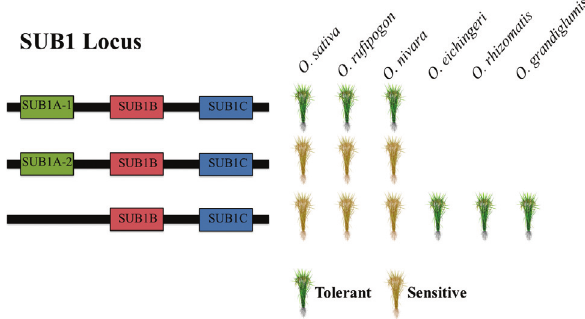
Figure 1 - Submergence tolerance and genetic architecture of SUB1 locus in cultivated and wild Oryza species. Genotypes from AA genome species Oryza sativa , Oryza rufipogon and Oryza nivara are tolerant or sensitive to submergence depending on the presence of SUB1A-1 allele of the SUB1A gene. Genotypes that either have SUB1A-2 allele or lack a SUB1A, carrying only SUB1B and SUB1C genes, are sensitive. Geno- types from CC genome species Oryza eichingeri , Oryza rhizomatis and the CCDD tetraploid species Oryza grandiglumis were shown to be toler- ant to submergence while carrying a SUB1A gene-lacking SUB1 locus, indicating the locus does not contribute to the stress tolerance in these spe-